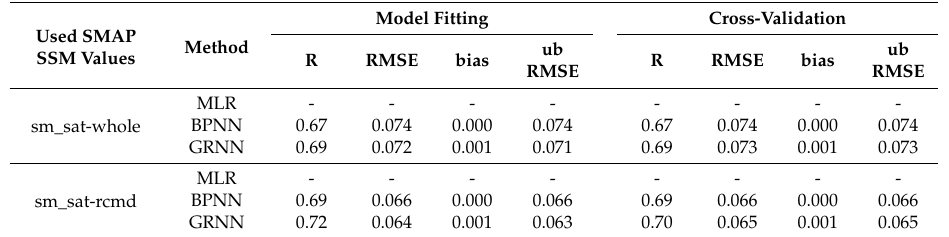
Table 4. Performance of the fusion models without time and location input